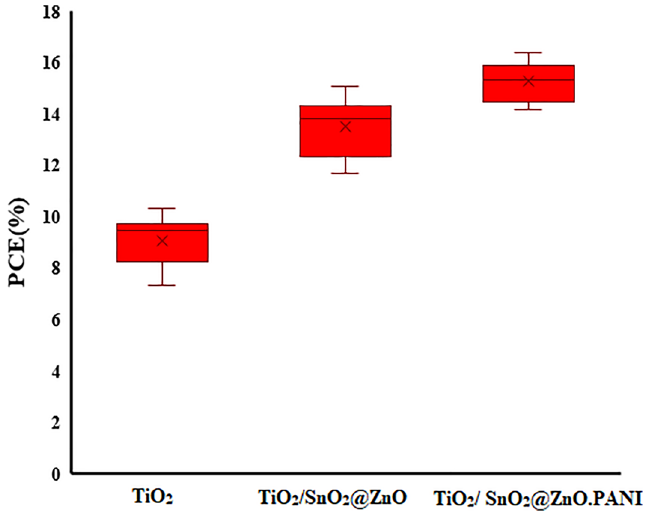
Figure 15. PCE histogram of 30 independent PSCs based on TiO 2 , TiO 2 /SnO 2 @ZnO nanocomposite, and TiO